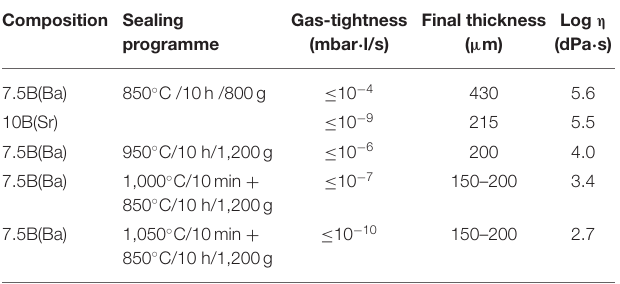
TABLE 2 | Gas-tightness (mbar · l/s) of the joints Crofer22APU/glass-ceramic/Crofer22APU as a function of the treatment time at 800 ◦ C and after thermal